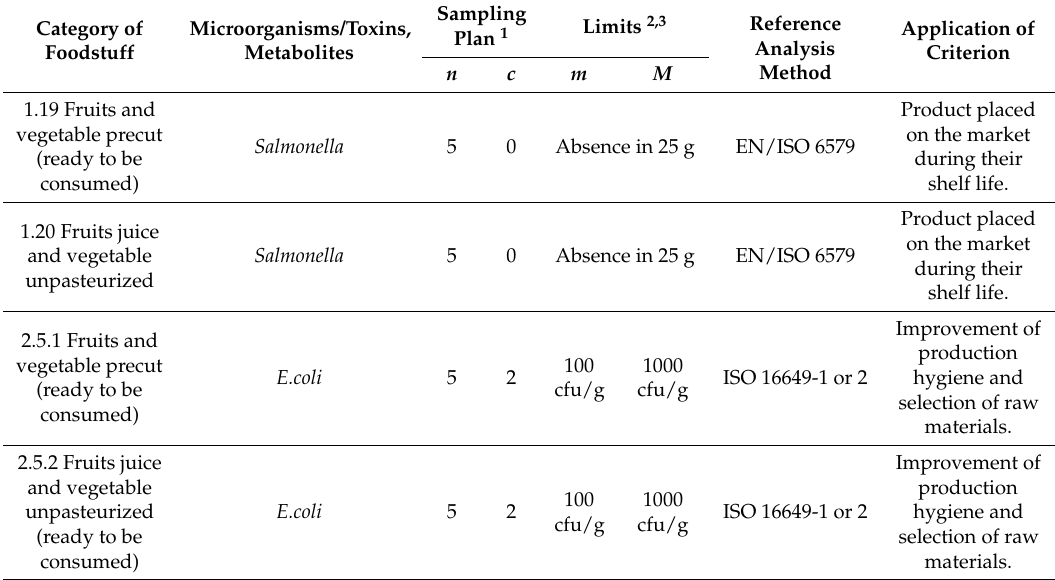
Table 2. Food safety criteria in the EU legislation for fruit/vegetable